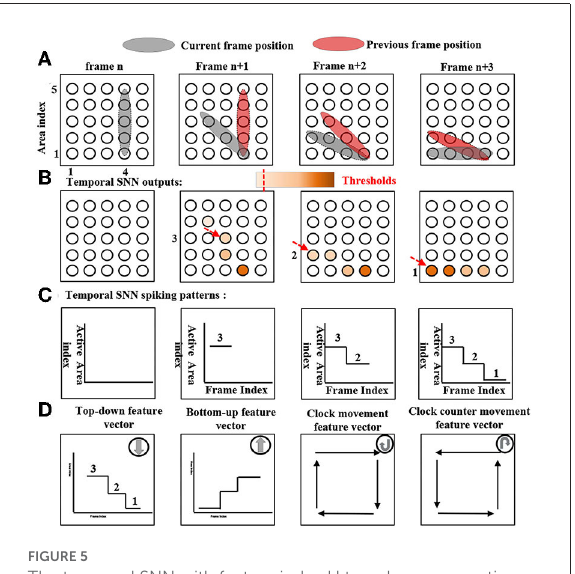
FIGURE5 The temporal SNN with feature index H top-down computing mechanism. Also, reference patterns of temporal SNNs with feature indexes E, F, and I are shown at bottom as well. (A) The object movement. (B) Temporal SNN outputs. (C) Detected temporal SNN spiking patterns. (D) Reference